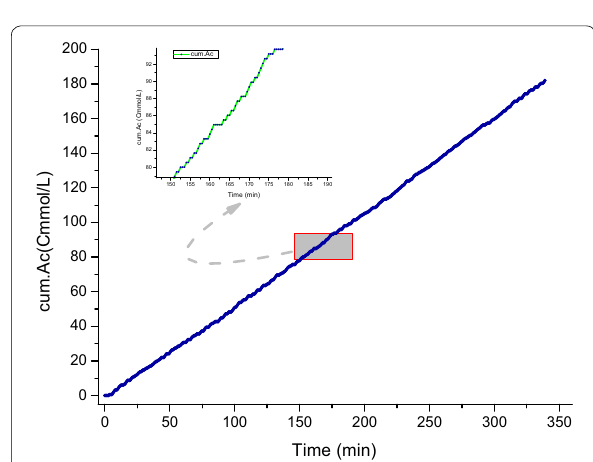
Fig. 4 The accumulative amount of HAc fed during the feast phase in a typical cycle applying the feed-on-demand